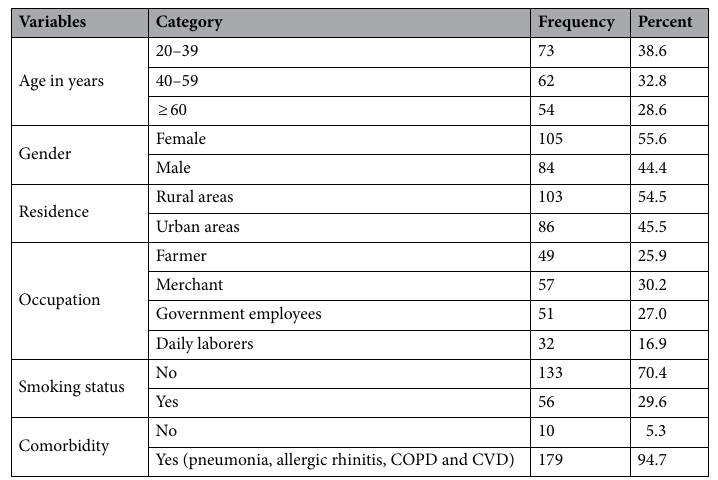
Table 1. Sociodemographic characteristics of adult patients assisted at the Adult Emergency Department of the Jimma Medical Center, Jimma Town, Ethiopia during 25 July, 2021 to 25 August, 2021. COPD chronic obstructive pulmonary diseases, CVD cardiovascular